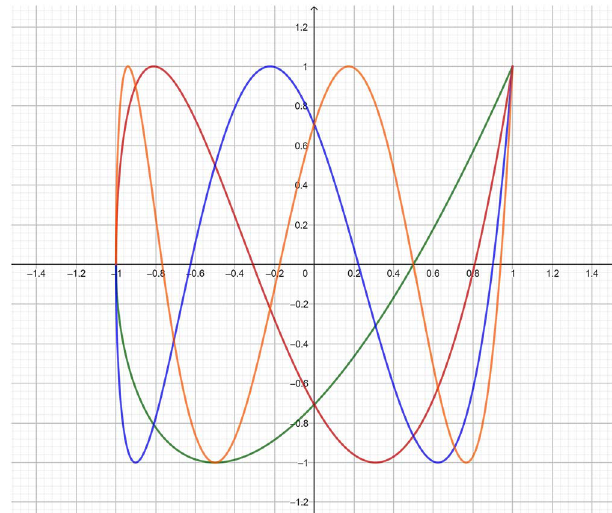
Figure 8. T k +1/2 ( x ), k = 1, 2, 3, 4. (1) Green; (2) red; (3) blue; (4) orange.